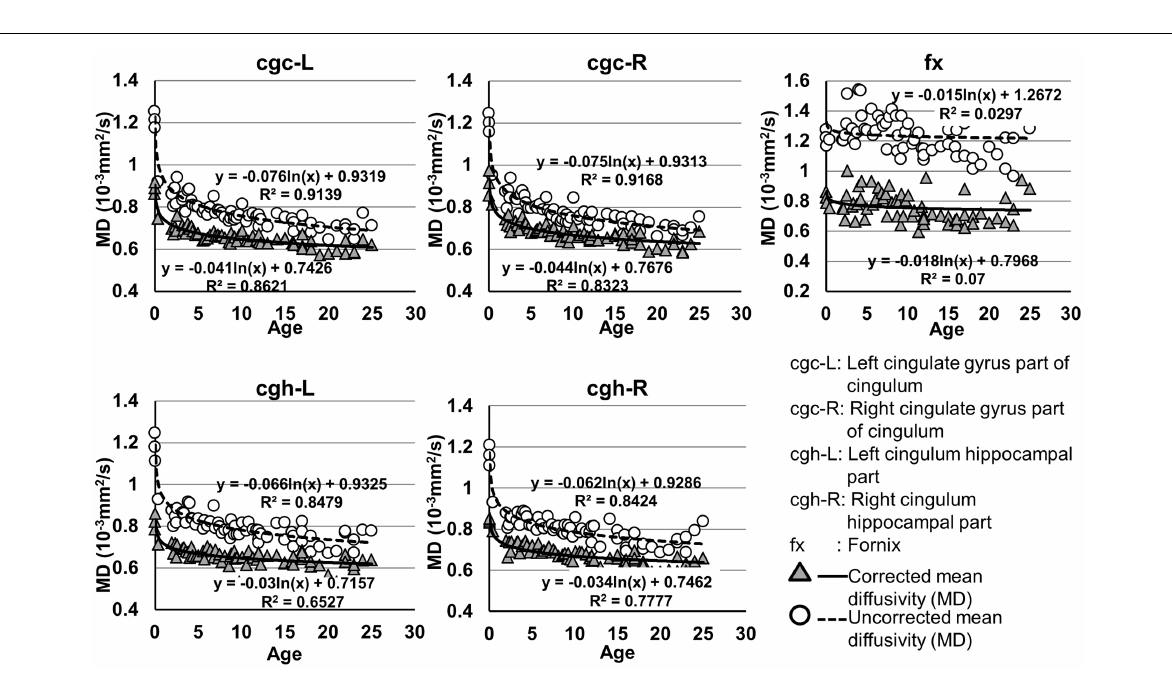
metric measurements of the limbic tract, also shown in Tables 1 – 4 . For rest of the fittings, there is no statistical difference between linear and logarithmic fitting. No significant difference between